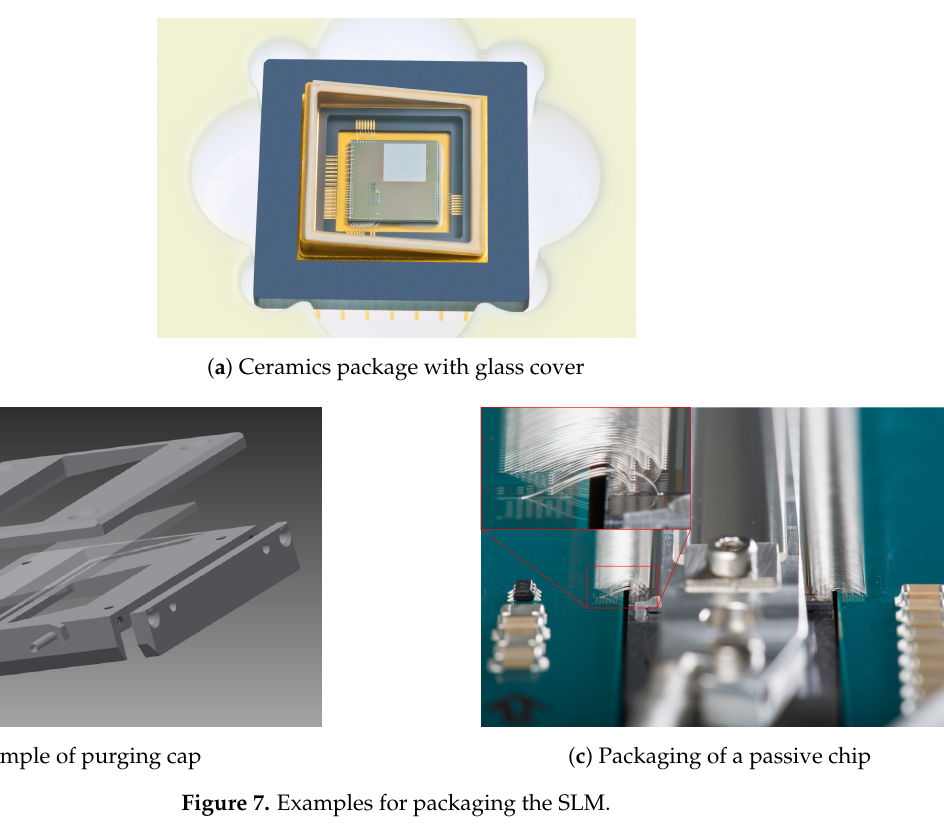
Figure 7. Examples for packaging the